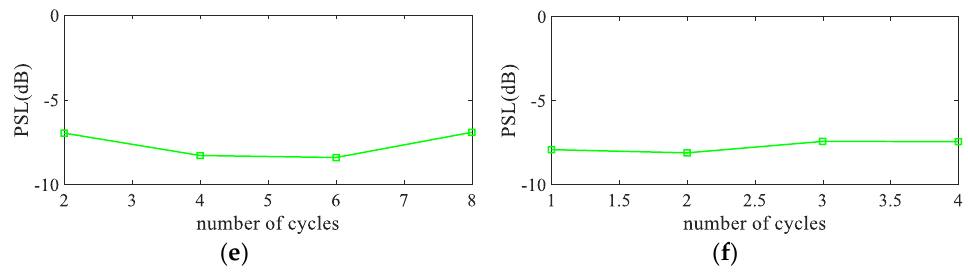
Figure 9. The effect analysis of carrier cycles on the amplitude of received signals and MLW, ( a ) 15-bit amplitude, ( b ) 15 − bit MLW, ( c ) 63 − bit amplitude, ( d ) 63 − bit MLW, ( e ) 15 − bit PSL, ( f ) 63 − bit PSL.